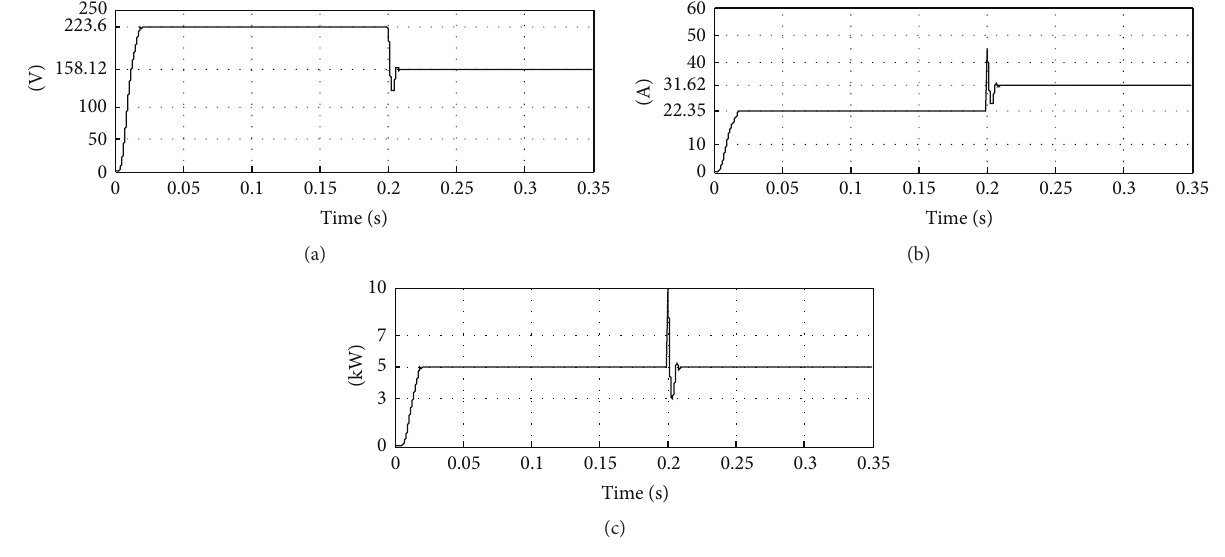
Figure 9: Simulation of buck-converter with constant power